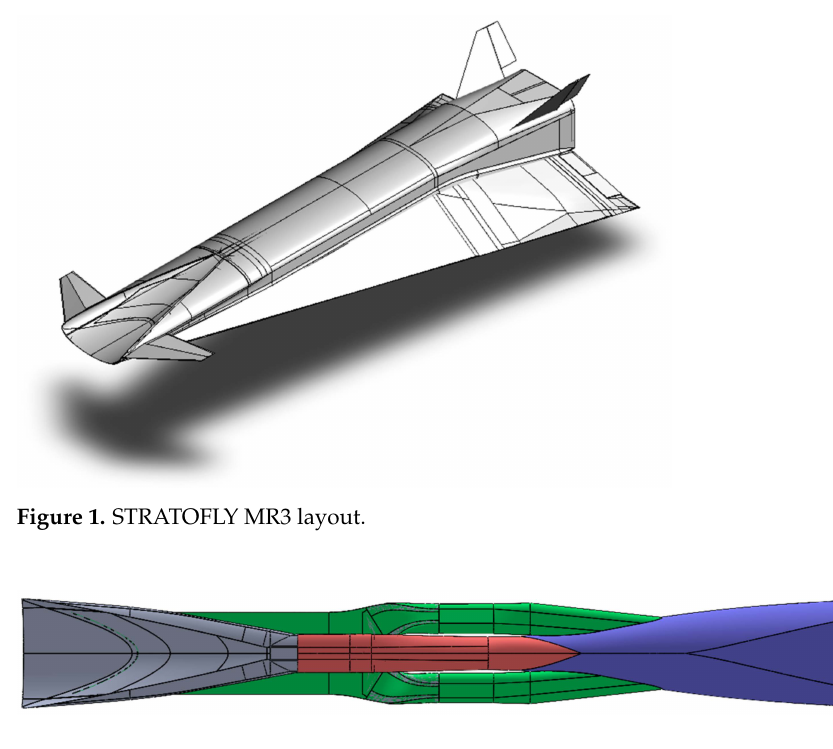
Figure 2. STRATOFLY MR3 propulsive flow